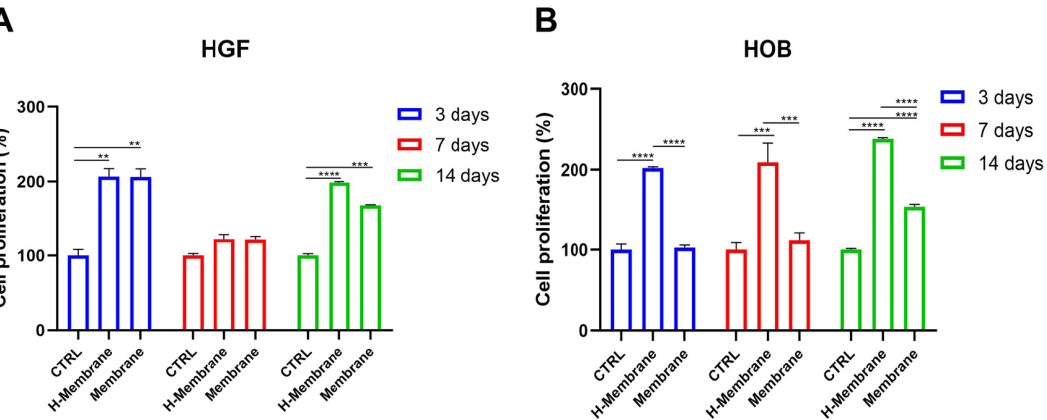
Figure 3. Cell proliferation of H-Membrane and Membrane after 3, 7, and 14 days of HGFs ( A ) and hOBs ( B ) cultures. (** p <0.001; ***, **** p < 0.0001).